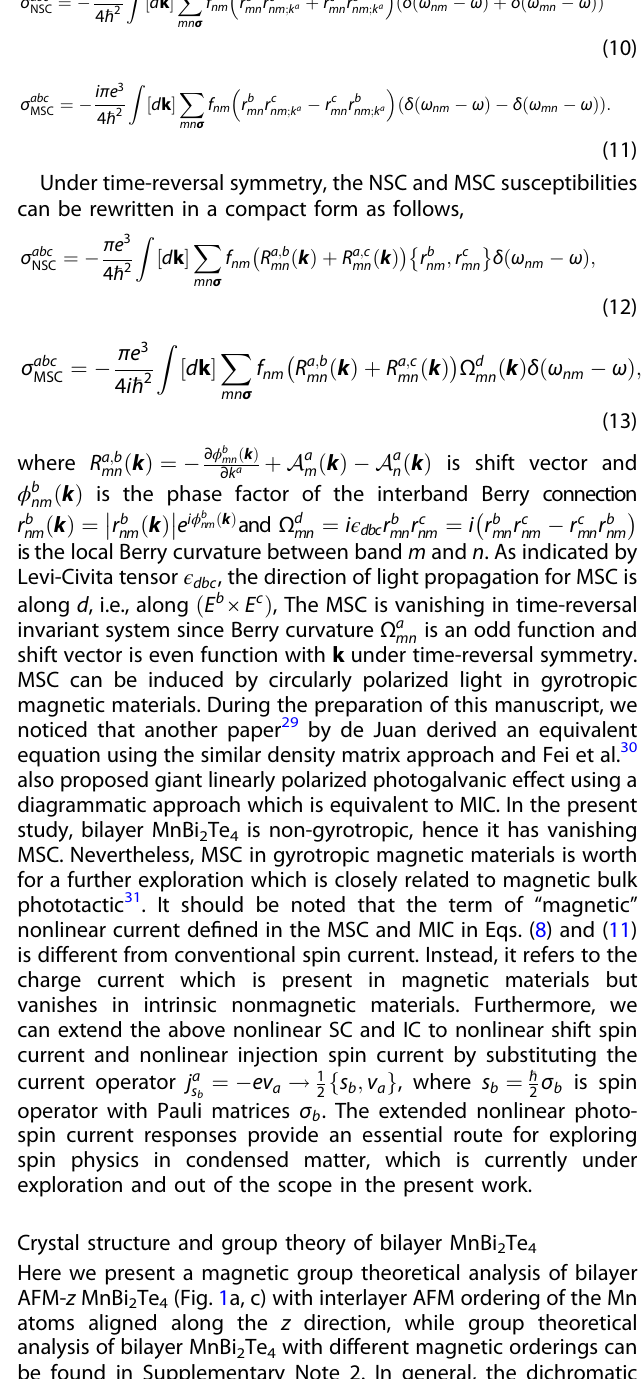
table of point group D 3 d is included in Supplementary Table